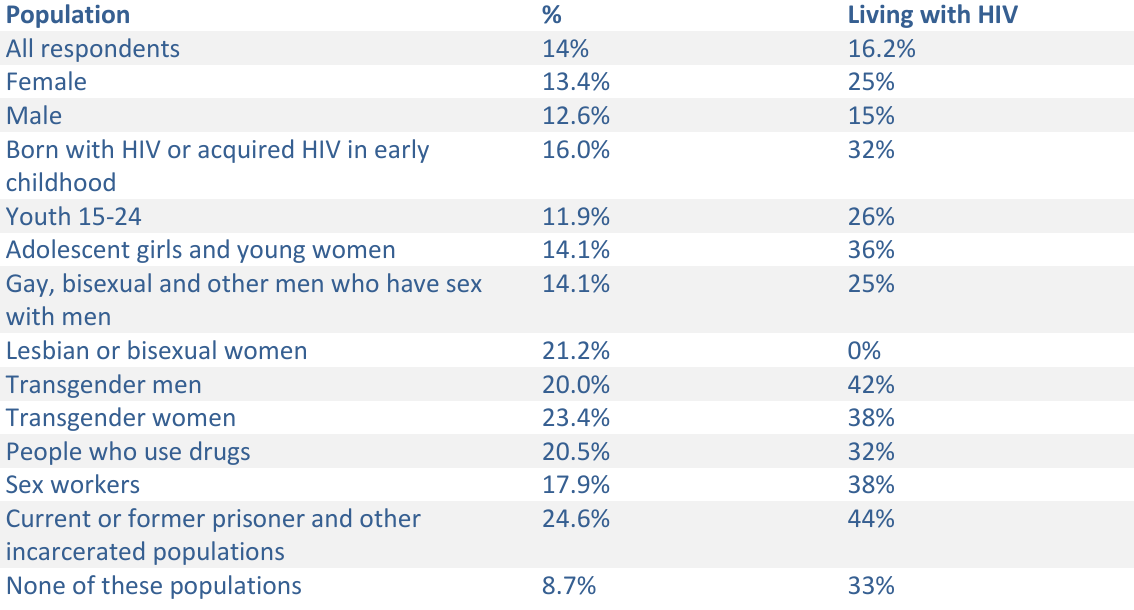
Table 2. % of respondents reporting worse-than-average living conditions compared to the general population in their country, by population and HIV status